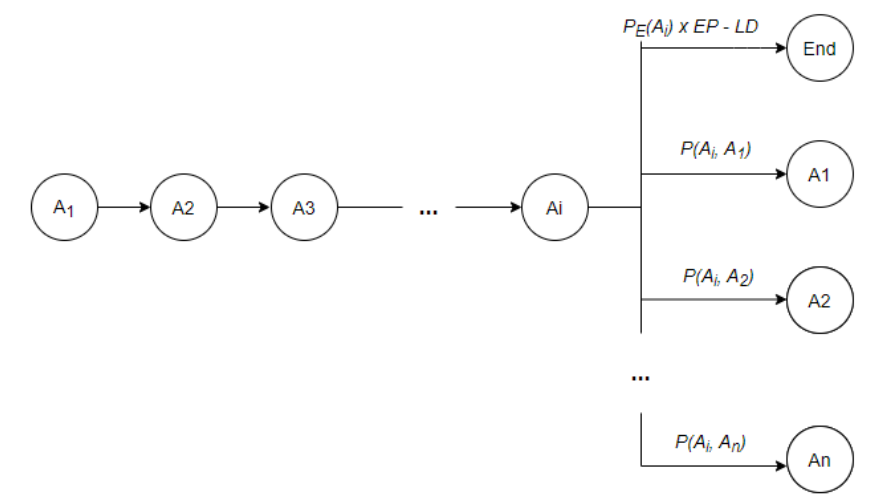
Figure 2. Activity selection in baseline detection process.